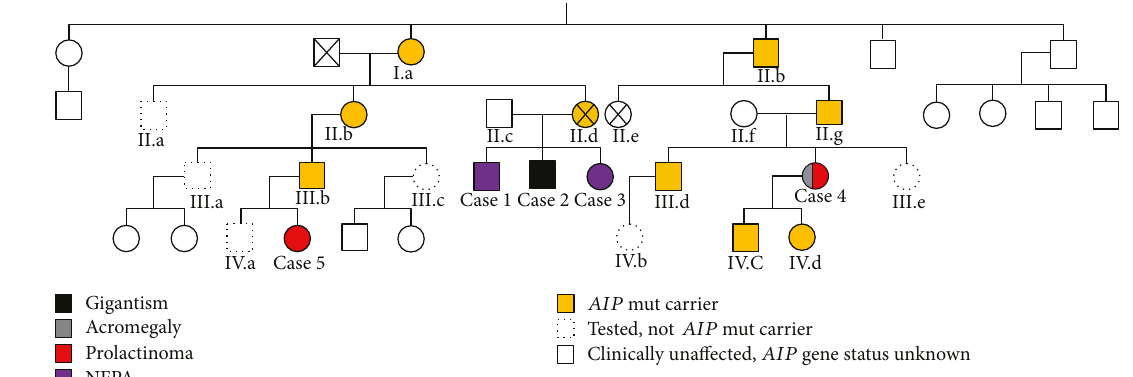
Figure 4: Pedigree